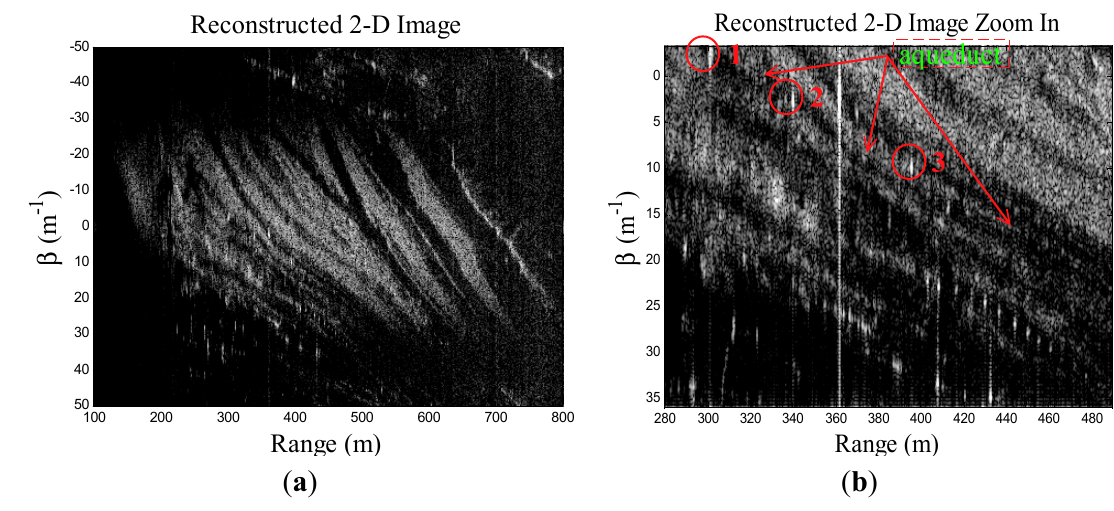
Figure 8. ( a ) Imaging result without overlapped sub-aperture processing. ( b ) Pipe line area zoom-in.